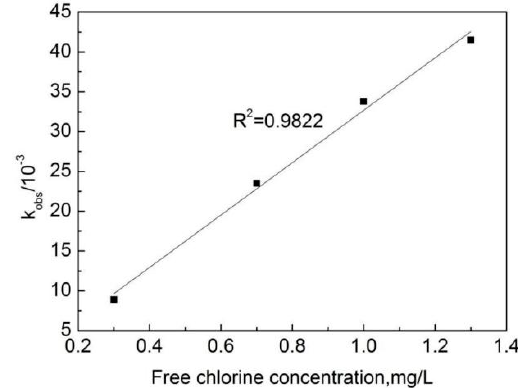
Figure 3. Dynamic fitting curves of OFL under different free chlorine concentrations in deionized water.